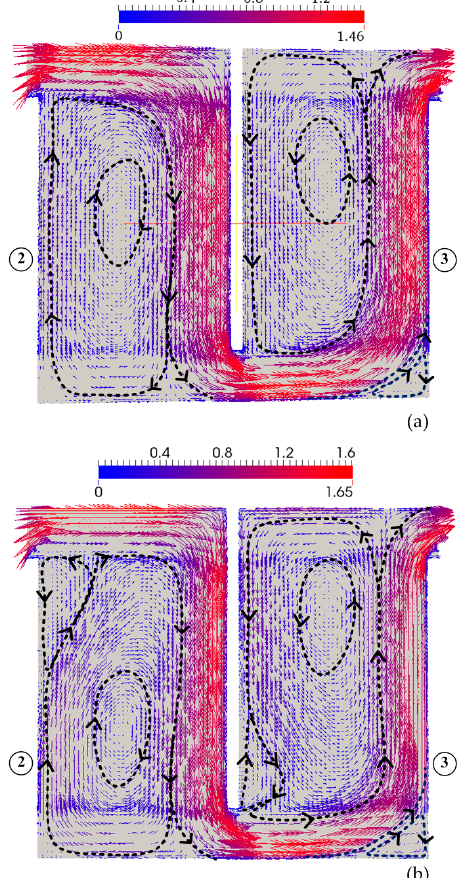
Figure 7. Dimensionless velocity vectors and recirculation regions in Chambers 2 and 3 on the x – y plane at z = L /2: ( a ) steady state flow field in RANS; ( b ) time ‐ averaged flow field in LES.